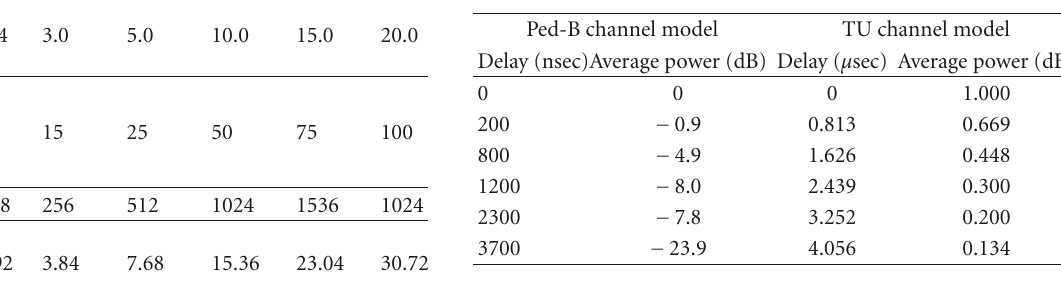
Table 1: System numerology. Table 2: Power delay profiles for pedestrian B and ITU channel